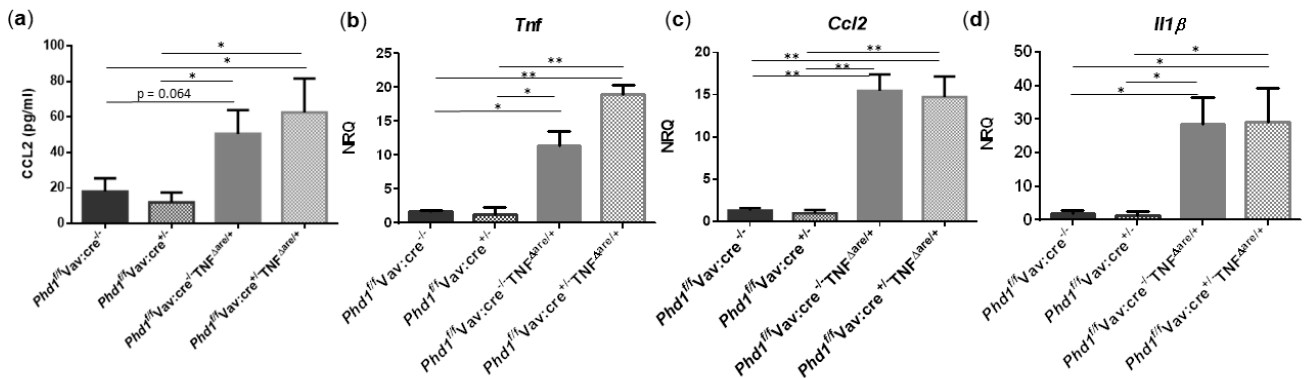
Figure 7. Haematopoietic deletion of Phd1 does not influence the proinflammatory gene expression profile in TNF ∆ ARE/+ mice. ( a ) Serum levels of CCL2 and mRNA expression levels of ( b ) Tnf, ( c ) Ccl2 and ( d ) Il1 β in the distal ileum of Phd1 f/f Vav:cre − / − , Phd1 f/f Vav:cre +/ − , Phd1 f/f Vav:cre +/ − TNF ∆ ARE/+ and Phd1 f/f Vav:cre +/ − TNF ∆ ARE/+ mice. * p < 0.05; ** p < 0.01. Data are represented as the mean ± SEM. NRQ: Normalized relative quantities.